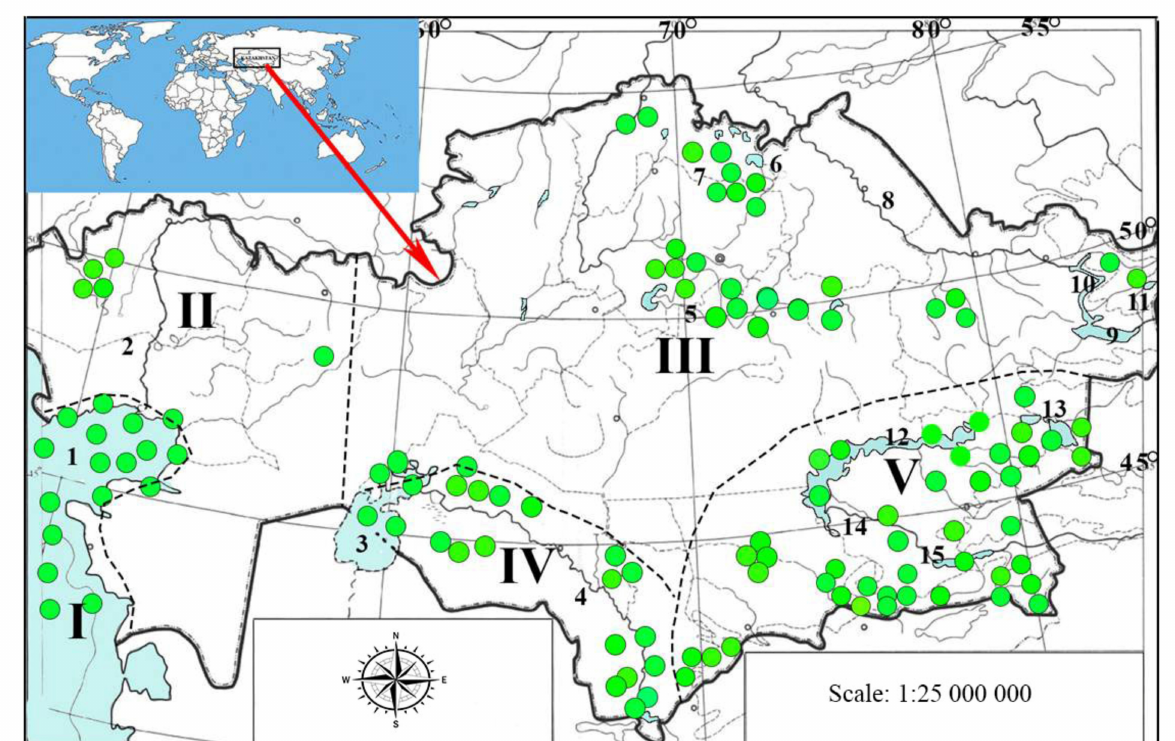
Figure 1. Schematic map of the location of the surveyed water bodies of Kazakhstan and their distribution by zoogeographic provinces and regions: I—Ponto–Caspian region, II-V—European–Siberian subregion of the Palaearctic region, including II—Volga–Ural province, III—Irtysh province, IV—Turkestan–Aral province, V—Balkhash province of the Nagorno–Asian region. Water bodies and systems of water bodies are designated in Arabic numerals: 1. The Caspian Sea, 2. Ural River, 3. The Aral Sea, 4. Syrdarya River, 5. Water bodies of the Nura River Basin, 6. Naurzum Lakes, 7. Shchuchinsko-Borovsk Lakes, 8. River Irtysh, 9. lake Zaysan, 10. Bukhtarma Reservoir, 11. Lake Markakol, 12. Lake Balkhash, 13. Alakol-Sasykol system of lakes, 14. Ili river, 15. Kapshagai